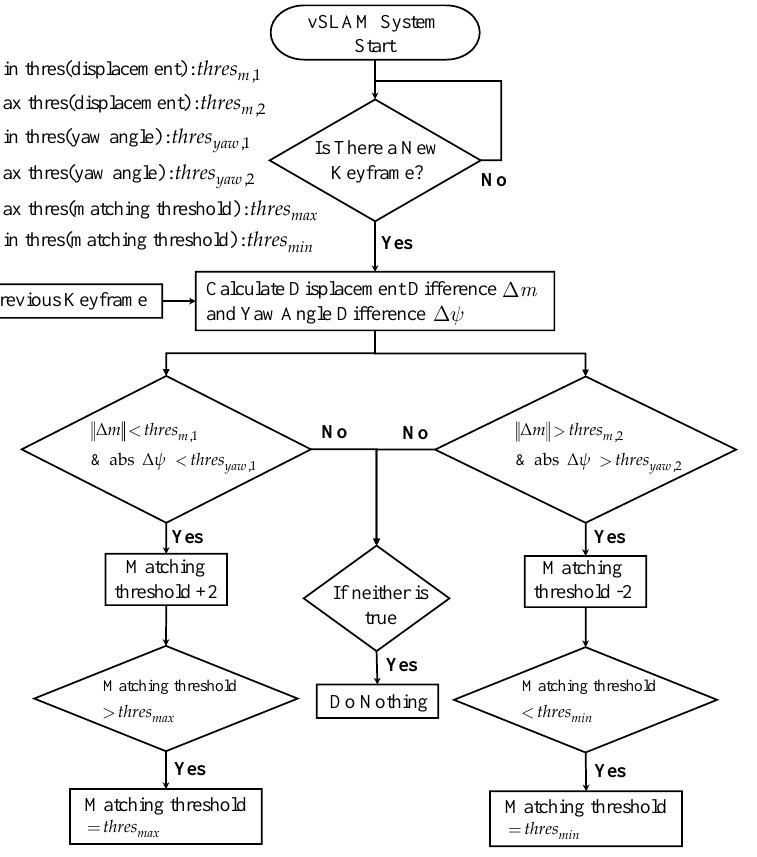
Figure 10. Flowchart of online adaptive matching threshold tuning algorithm. Table 2. Parameter settings for the proposed online adaptive matching threshold tuning algorithm.